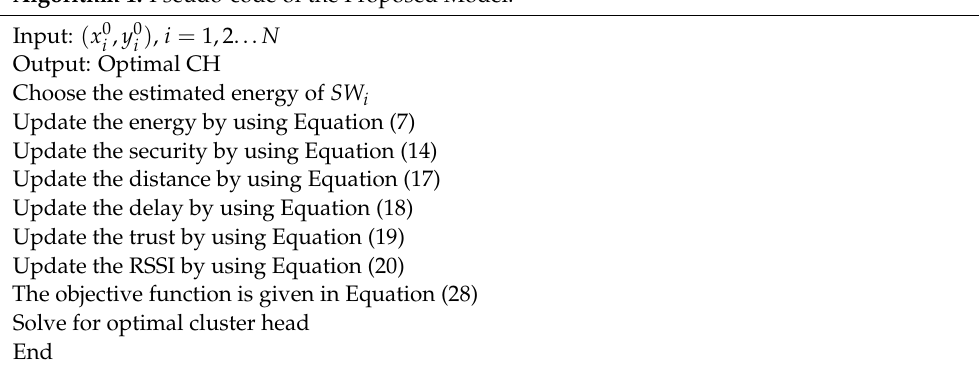
Algorithm 1. Pseudo-code of the Proposed